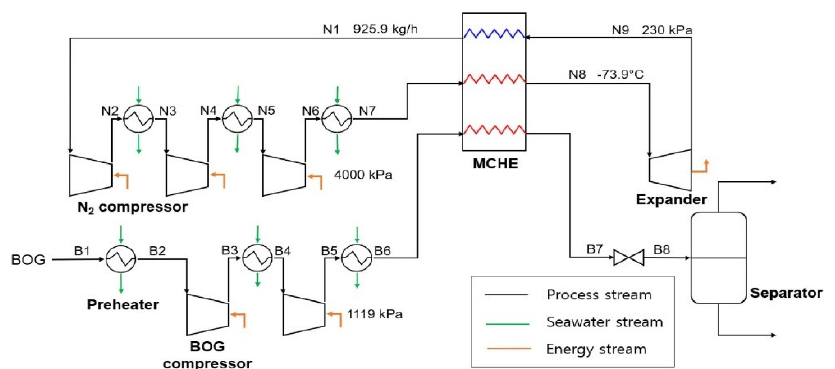
Figure 12. Process flowsheet for a single expander LNG process [53].